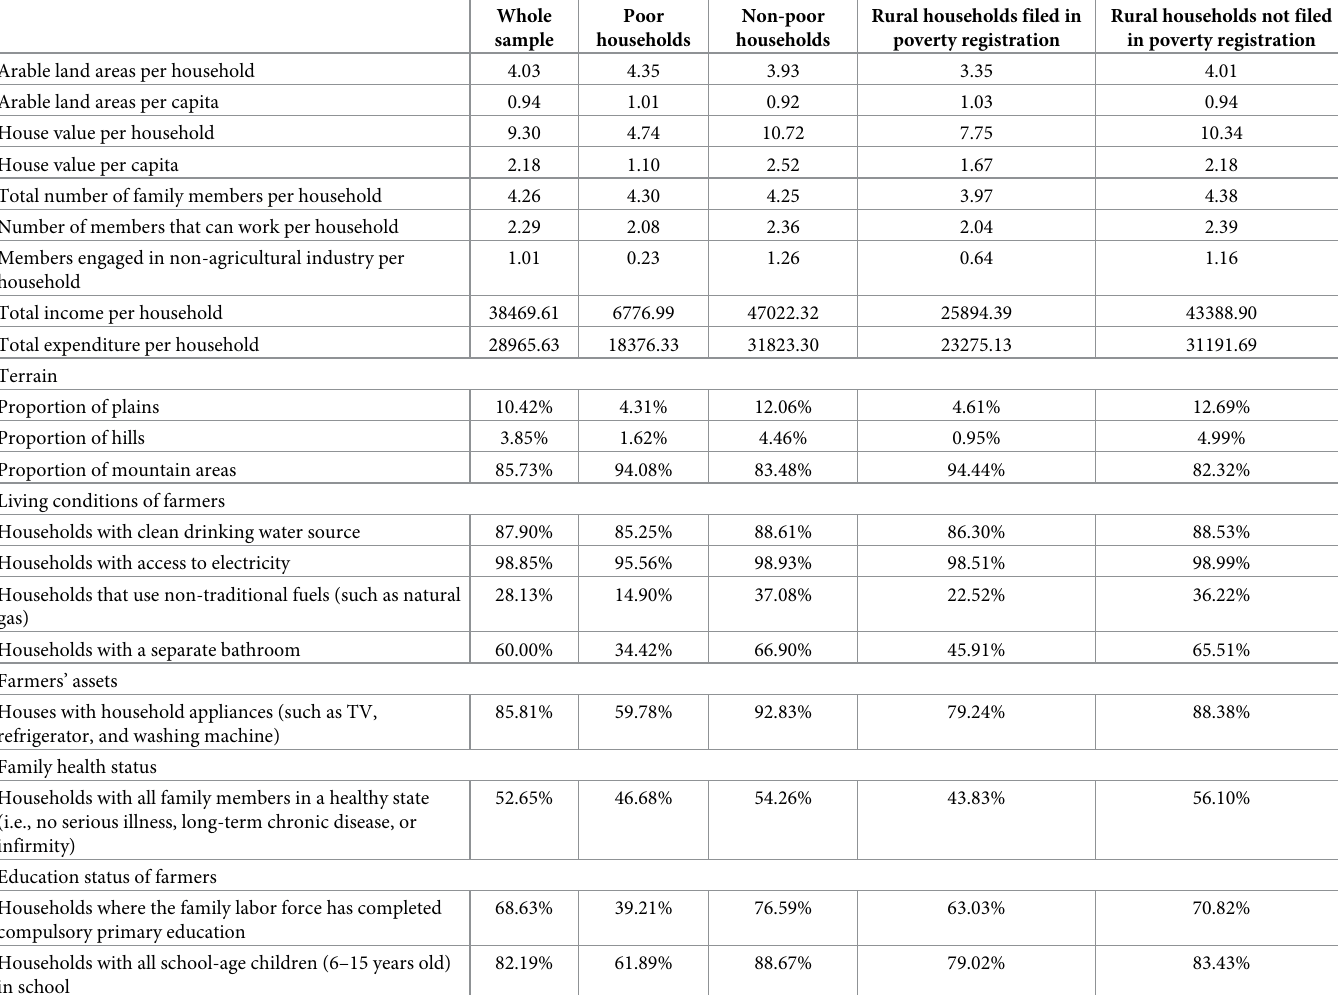
Table 2. Comparison of the statuses of poor